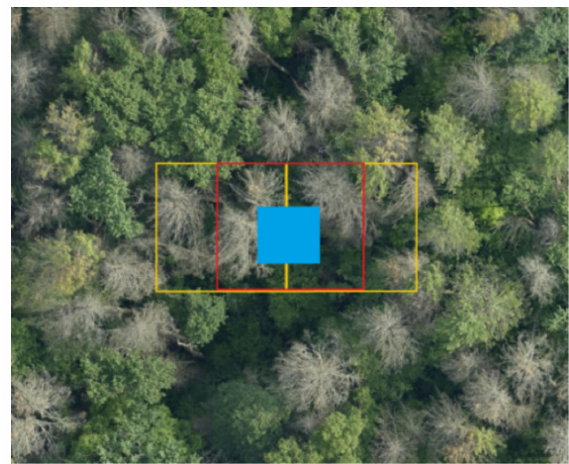
Figure 5. Schematic diagram of inflation prediction.